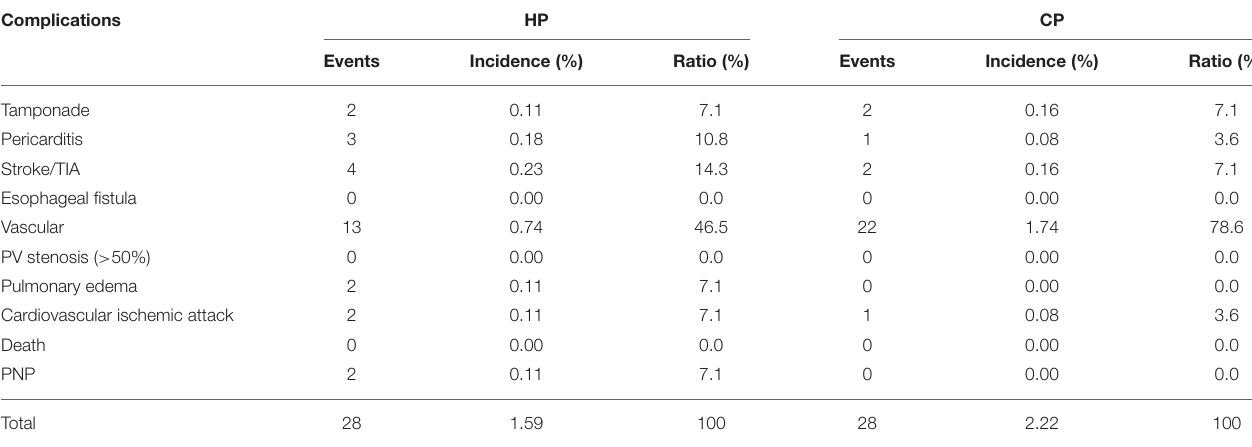
TABLE 7 | Details of procedure-related